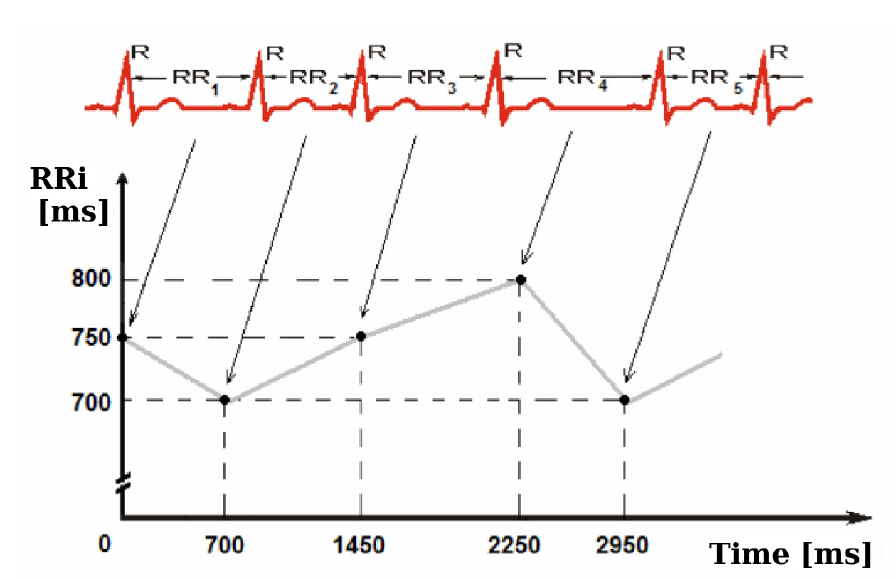
Figure 1: Determination of RR timings from ECG